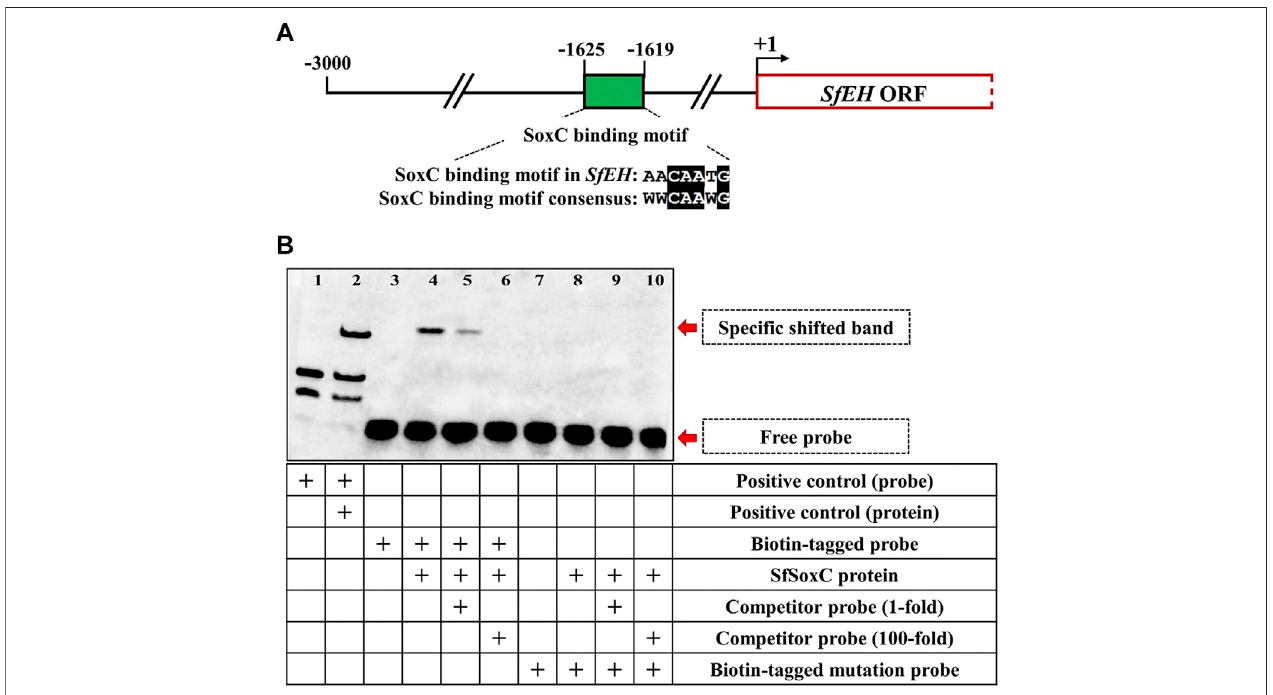
FIGURE 5 | The SfSoxC directly binds to the promoter of SfEH . The binding motif of SfSoxC identi fi ed in the promoter of SfEH was con fi rmed by EMSA. (A) The predicted Sf-SoxC-bindingmotif(5 ′ -AACAATG-3 ′ )inthe SfEH promoterregion.Thenumbers indicate thedistancefrom thestartcodon(+1)of SfEH gene.Theputative SfSoxC-binding motif in SfEH promoter region is aligned with the motif consensus sequence (5 ′ -WWCAAWG-3 ′ ). (B) Lane 1 and 2 is the positive control. Lane 3 is the biotin-tagged probe loading only. Lane 4, there is a speci fi c shift band when SfSoxC protein and biotin-tagged probe were incubated together. The competition assays showed that the speci fi c band became weak with the addition of a 1-fold molar excess of unlabeled probe (competitor probe) and completely disappeared with the addition of a 100-fold molar excess of unlabeled probe (lanes 5 and 6, respectively). There is no speci fi c band shifting when biotin-tagged mutation probe was incubated with SfSoxC protein (lane 8, 9 and